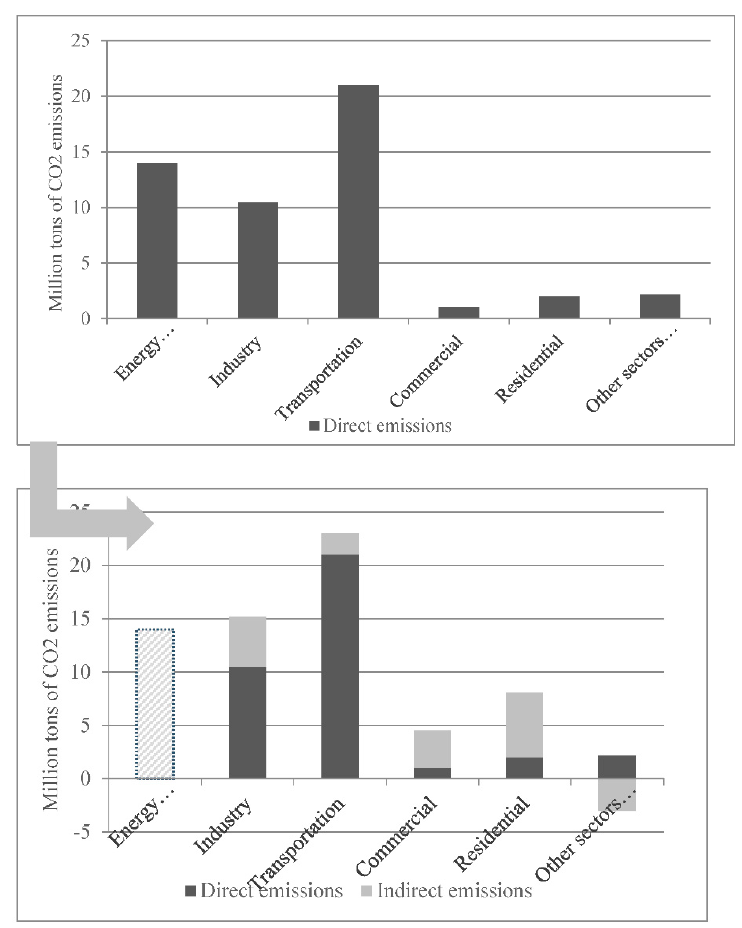
Figure 2. Re-distributing emissions from the utilities sector to the productive sectors (an illustrative example based European Energy Agency